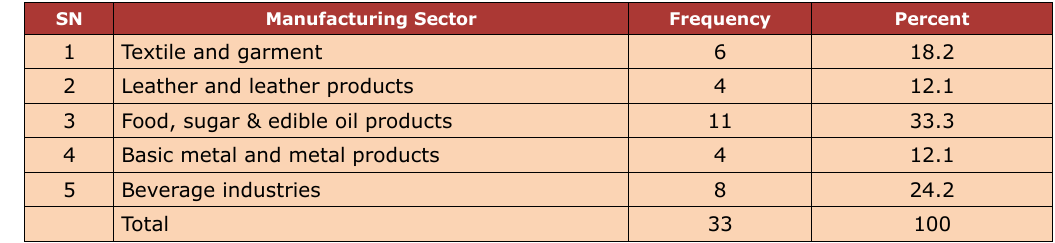
Table 2. Sampled companies in five manufacturing sectors